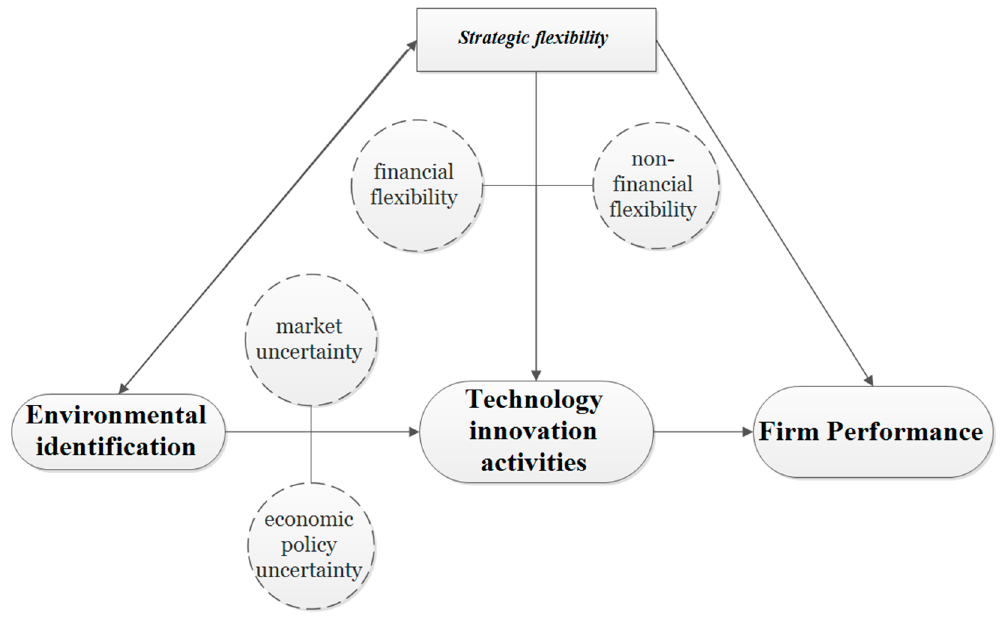
Figure 2. Conceptual